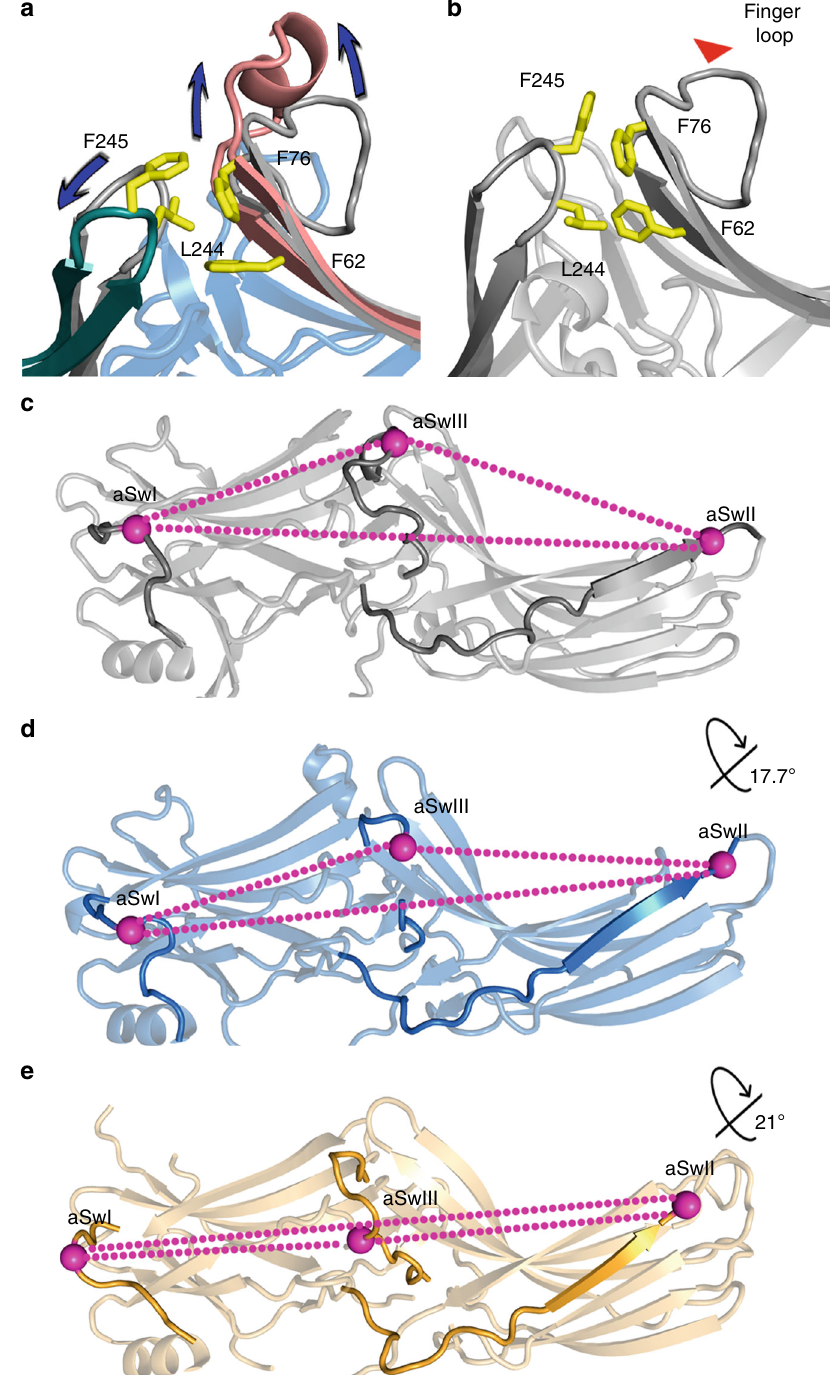
Fig. 6 Mechanisms of arrestin activation and domain rotation. a Overlay of the hydrophobic core between β -strands supporting the fi nger loop (pink) and the C-loop (green) in the active arrestin-3 and in the basal arrestin-3 (gray, PDB 3P2D 6 ). b Conformation of hydrophobic core between β -strands surrounding the fi nger loop and the C-loop in the basal arrestin-3 (PDB 3P2D 6 ). c – e The inter-domain twist realigns the arrestin switch regions. In each panel, the switch regions are darker elements; magenta balls mark equivalent residues. c Basal arrestin-3 (PDB 3P2D 6 ). d IP 6 -activated arrestin-3 with a 17.7° inter-domain rotation. e p44 arrestin-1 (PDB 4J2Q 10 ) with a 21° inter-domain